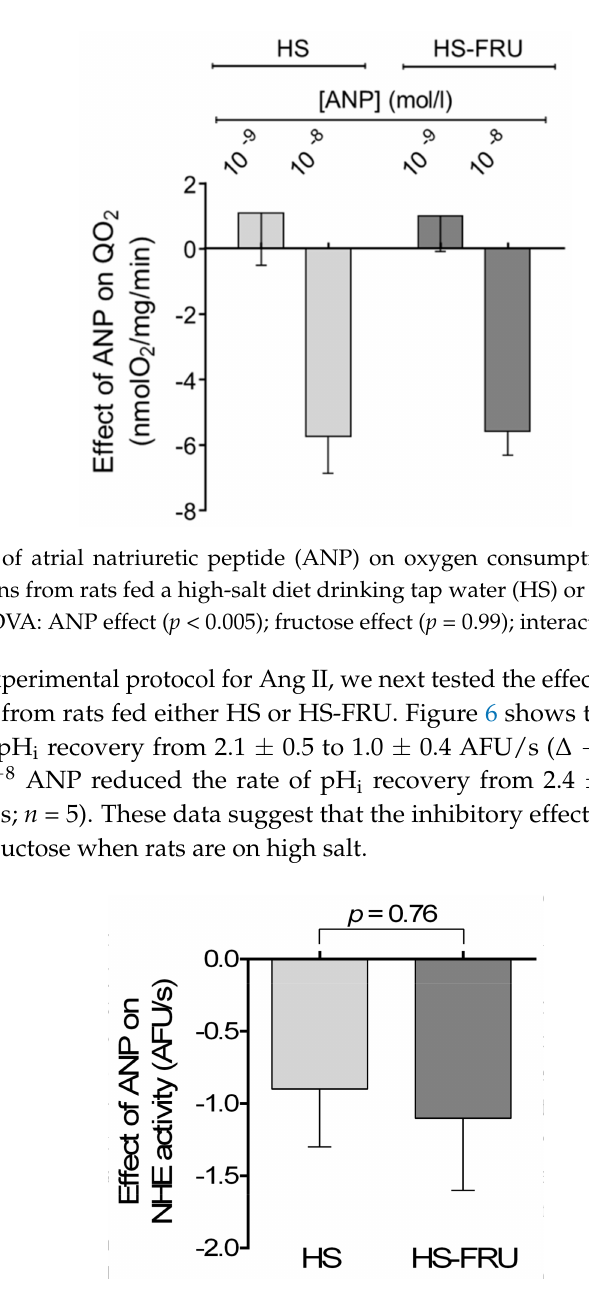
Figure 6. Effect of 10 − 8 mol/L atrial natriuretic peptide (ANP) on Na + /H + -exchanger (NHE) activity in proximal tubules isolated from rats fed a high-salt diet drinking tap water (HS) or 20% fructose